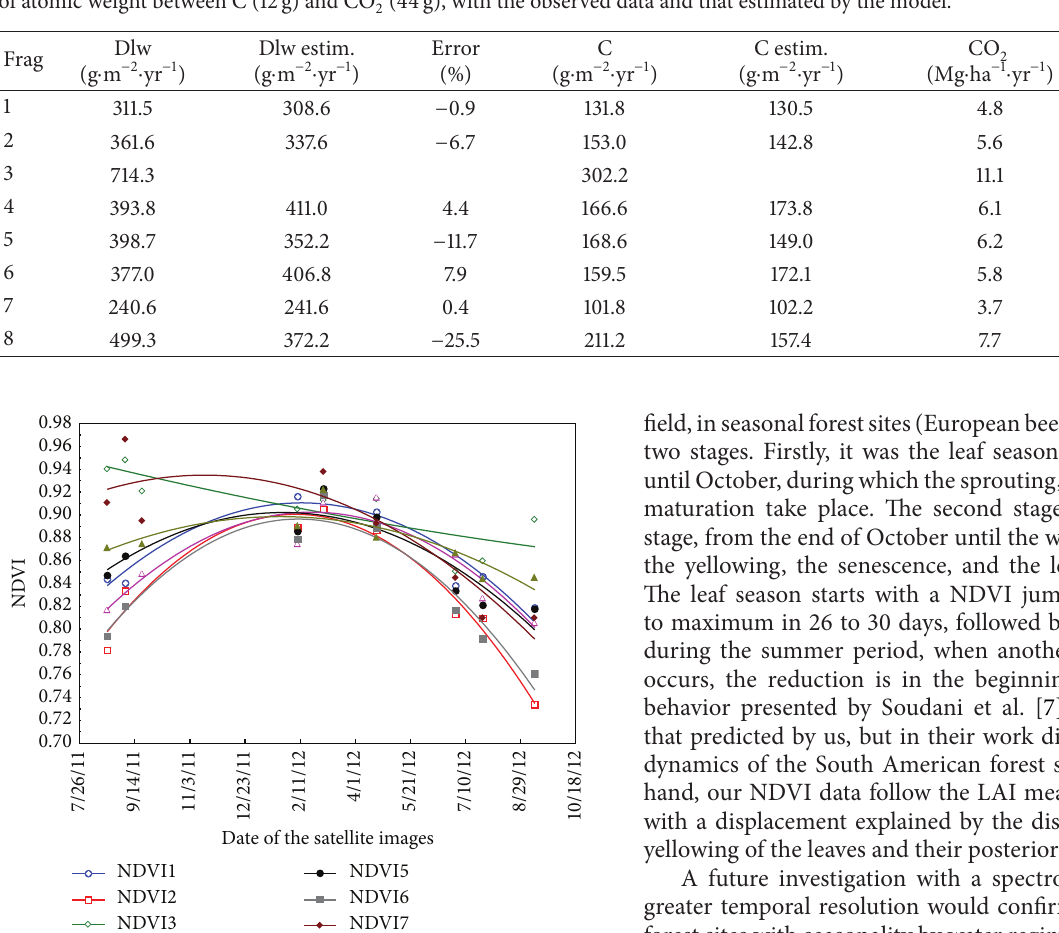
, bytheequivalence 2